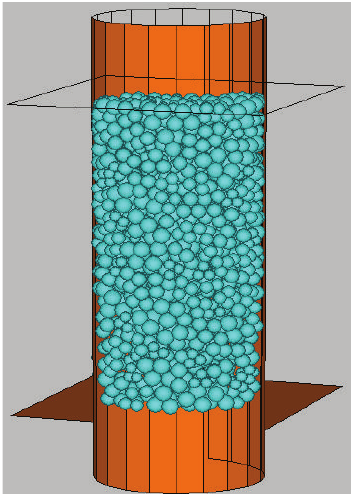
Figure 3: Sample and loading plane.